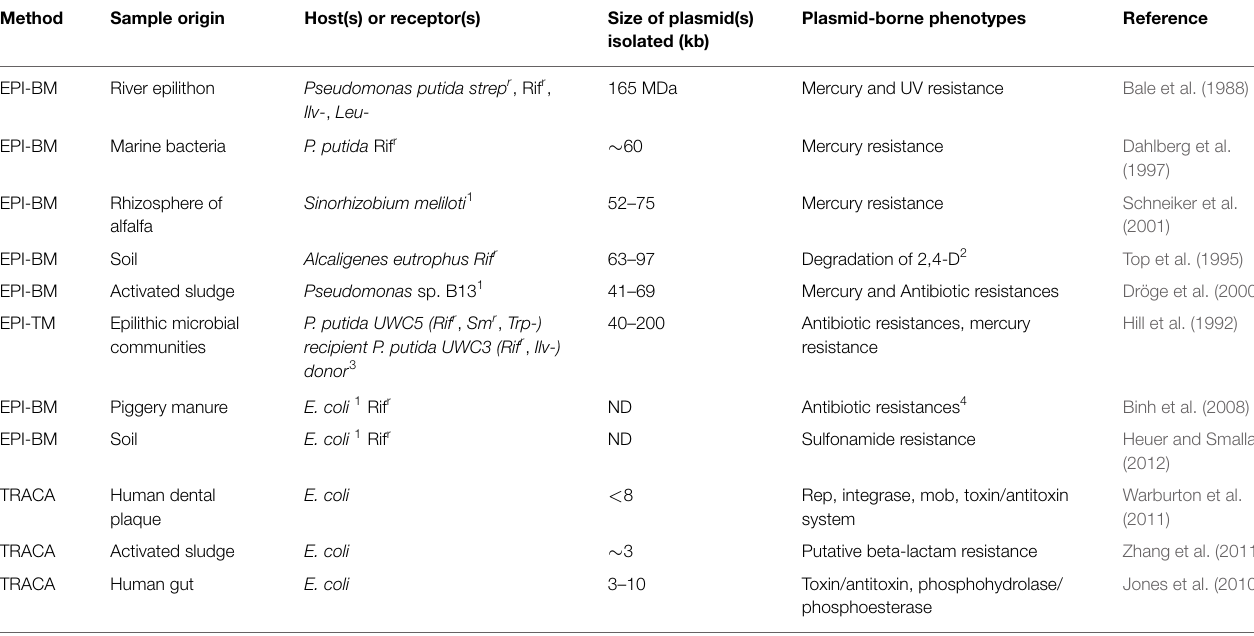
TABLE 1 | Examples of exogenous plasmid isolation and transposon aided capture